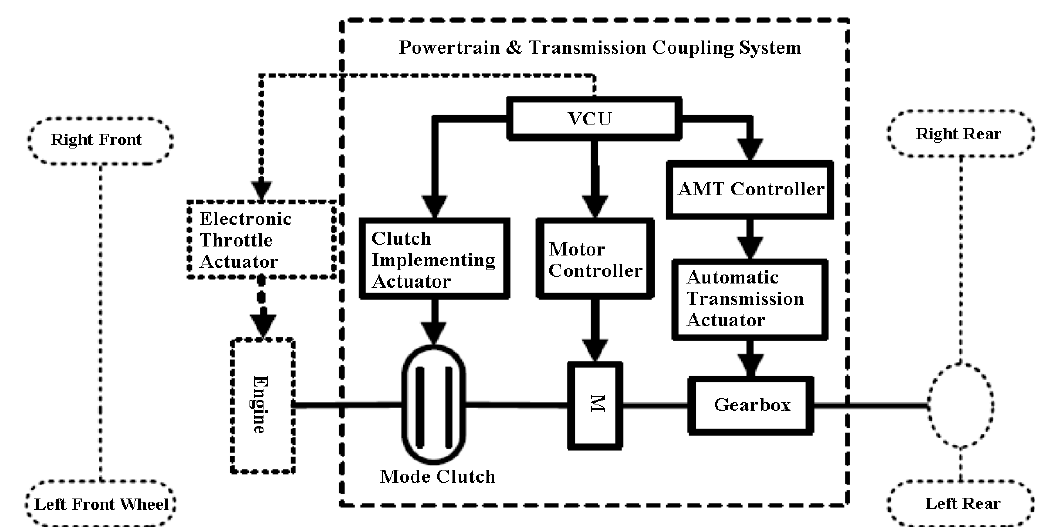
Figure 12. Structure of the parallel HEV